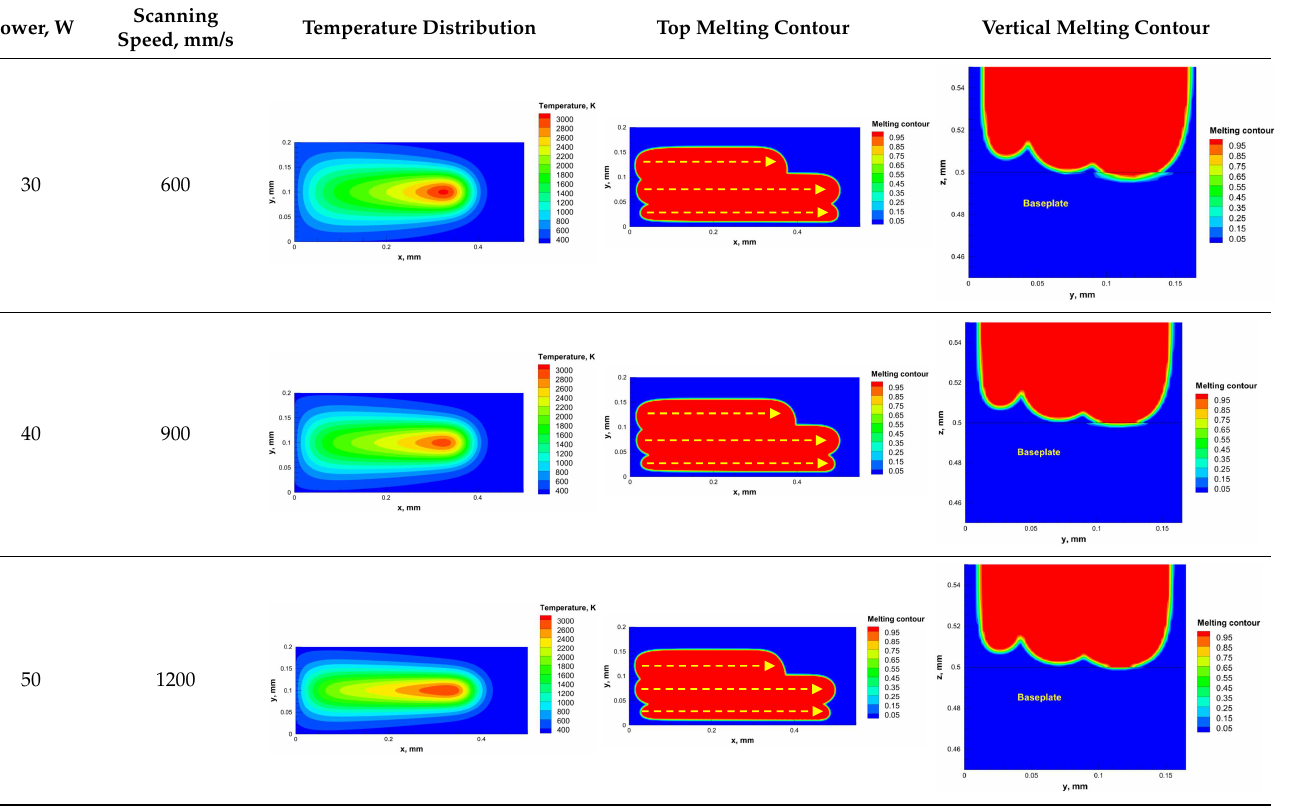
Table 6. Temperature distribution and melting contour obtained from the numerical model. Table 6 . Temperature distribution and melting contour obtained from the numerical model. Table 6 . Temperature distribution and melting contour obtained from the numerical model. Table 6 . Temperature distribution and melting contour obtained from the numerical Table 6 . Temperature distribution and melting contour obtained from the numerical model. Table 6 . Temperature distribution and melting contour obtained from the numerical model.